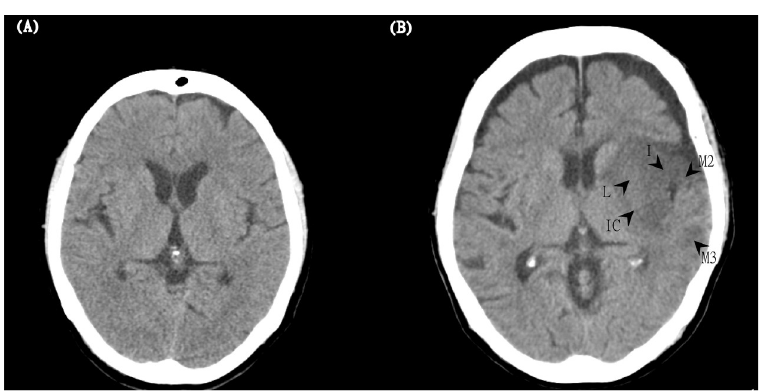
Fig 1. Two representative images of the clinical-CT-mismatch-positive (P group) and clinical-CT-mismatch- negative (N group). (A) The left panel (the P group) shows a 67-year-old woman with an NIHSS score of 16 and a CT-ASPECTS score of 10 at baseline. After IV thrombolysis, the patient had a good outcome (mRS = 0) at 3 months. (B) The right panel (N group) shows an 81-year-old woman with an initial NIHSS score of 22 and a CT-ASPECTS score of 5. Arrows show hypoattenuation in regions of the lentiform nucleus (L), internal capsule (IC), insula (I), M2, and M3. Although she received IV thrombolytic therapy, her mRS score was 5 at 3 months.